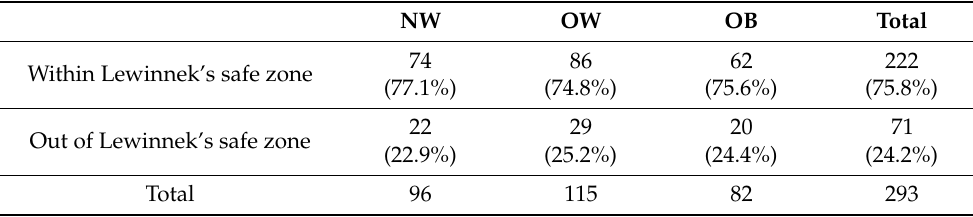
Table 4. Distribution of acetabular cup